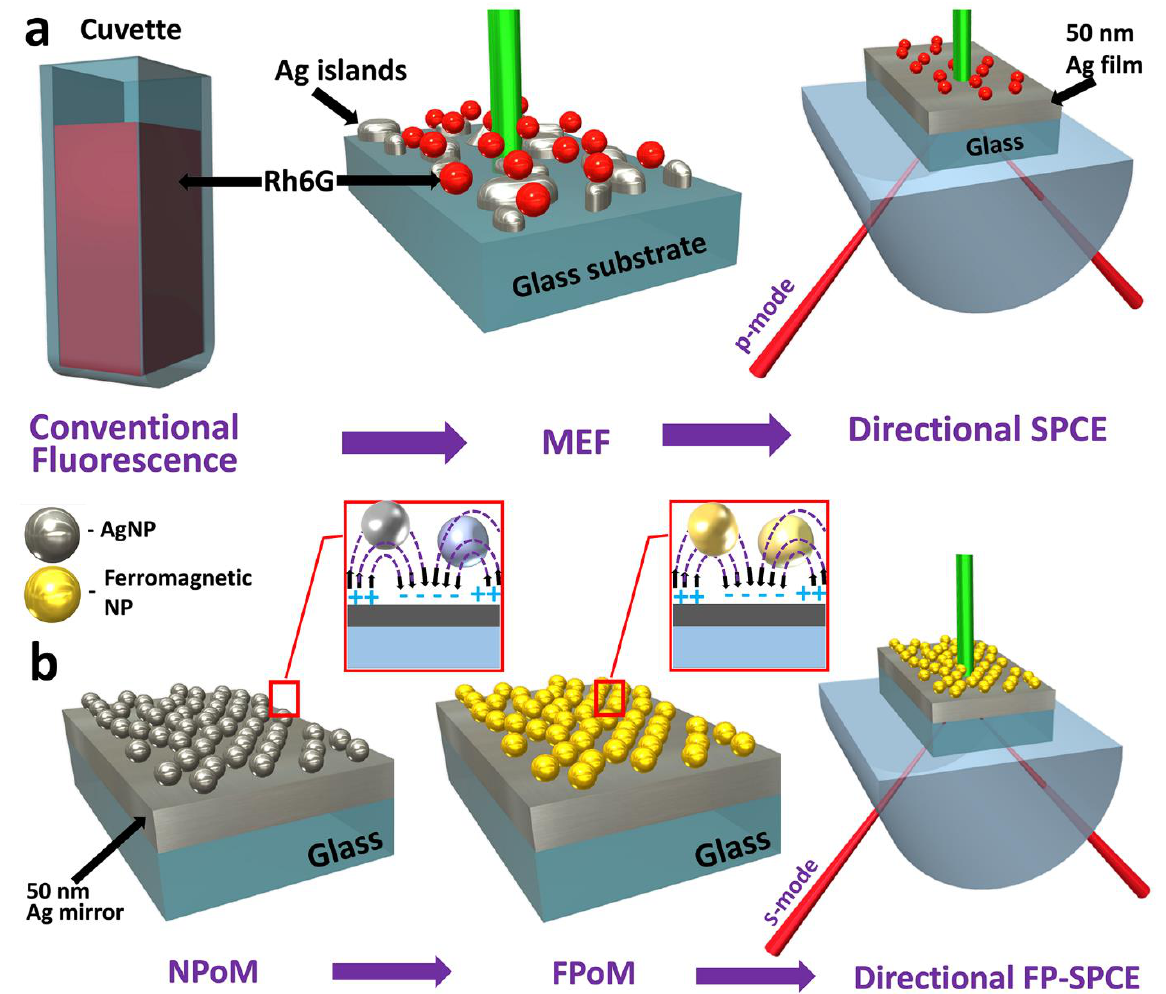
Figure 3. ( a ) Progress in conventional fluorescence-based detection techniques towards metal-enhanced fluorescence (MEF) and directional surface plasmon-coupled emission (SPCE) technology using metallic thin films. ( b ) Progress in Nanoparticle-on-mirror (NPoM) achieved towards Ferroplasmon-on-mirror (FPOM) to realize Ferroplasmon-coupled SPCE technology. Interestingly, the polarization of the out-coupled emission can be tuned from p-polarized to s-polarized by changing the nanointerface from spacer to cavity for the same material, with the use of ferroplasmons Adapted with permission from [71].